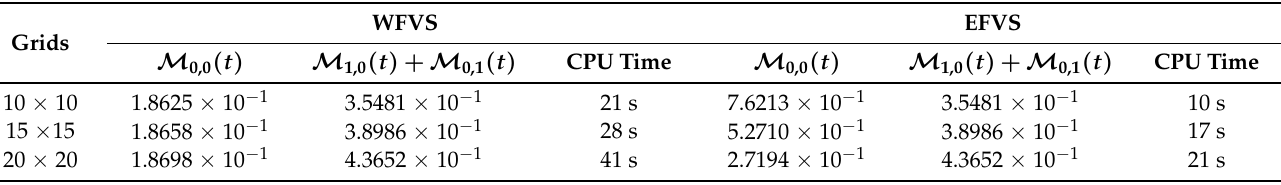
Table 5. Relative error for the weighted moments at different grid points for the test case with S = x + y and breakage function b 2 at t =